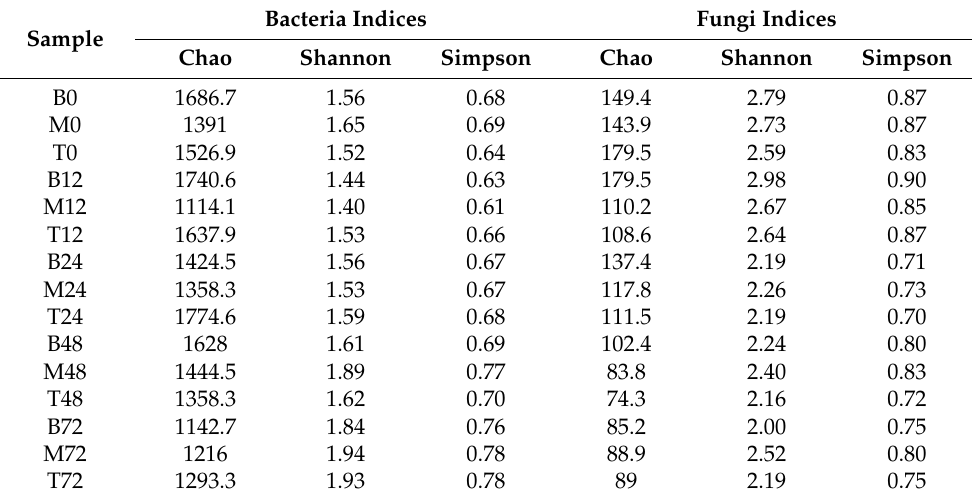
Table 1. Microbial community richness and diversity in different layers of a static coffee beans fermentation tank conducted at different times (24, 48, and 72